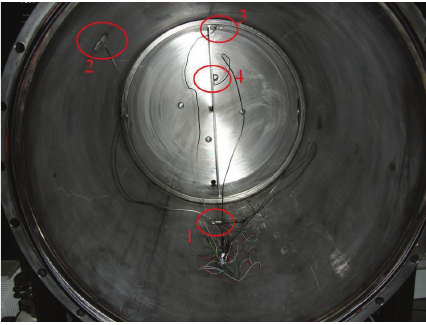
Figure 11: Thermocouples inside